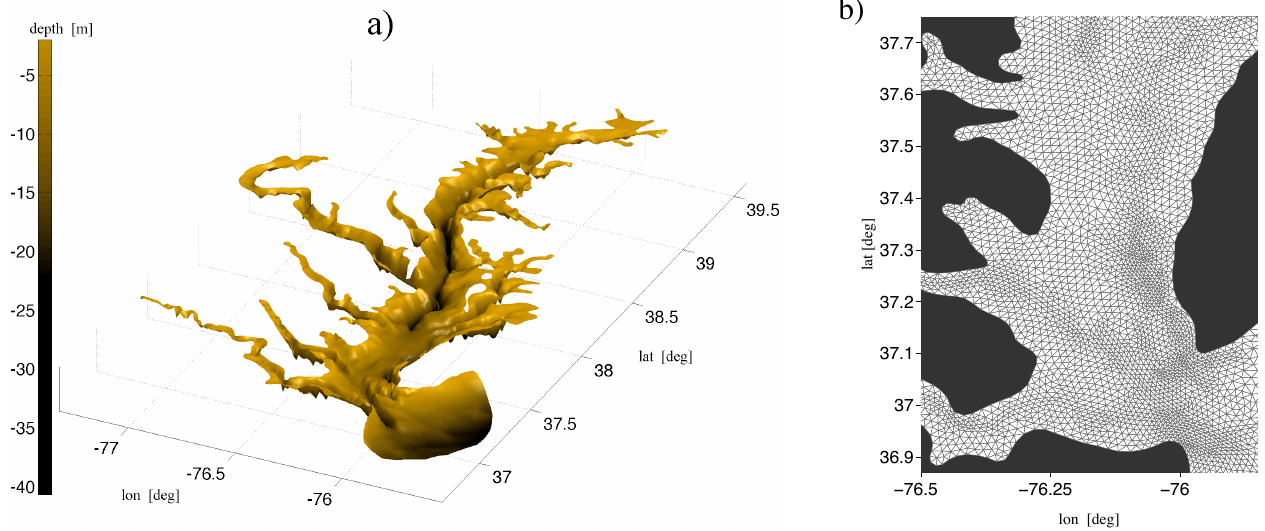
Fig. 1. (a) Bathymetry of Chesapeake Bay and its adjacent coastal area. The depths in the paleochannel in the main stem generally exceed 15m with a maximum depths of 63m. The rest of the bay is quite shallow with an average depth of 8.42m. (b) A fragment of the mesh resolving each of the 15 sigma layers in the model; the mesh is structured in the vertical.